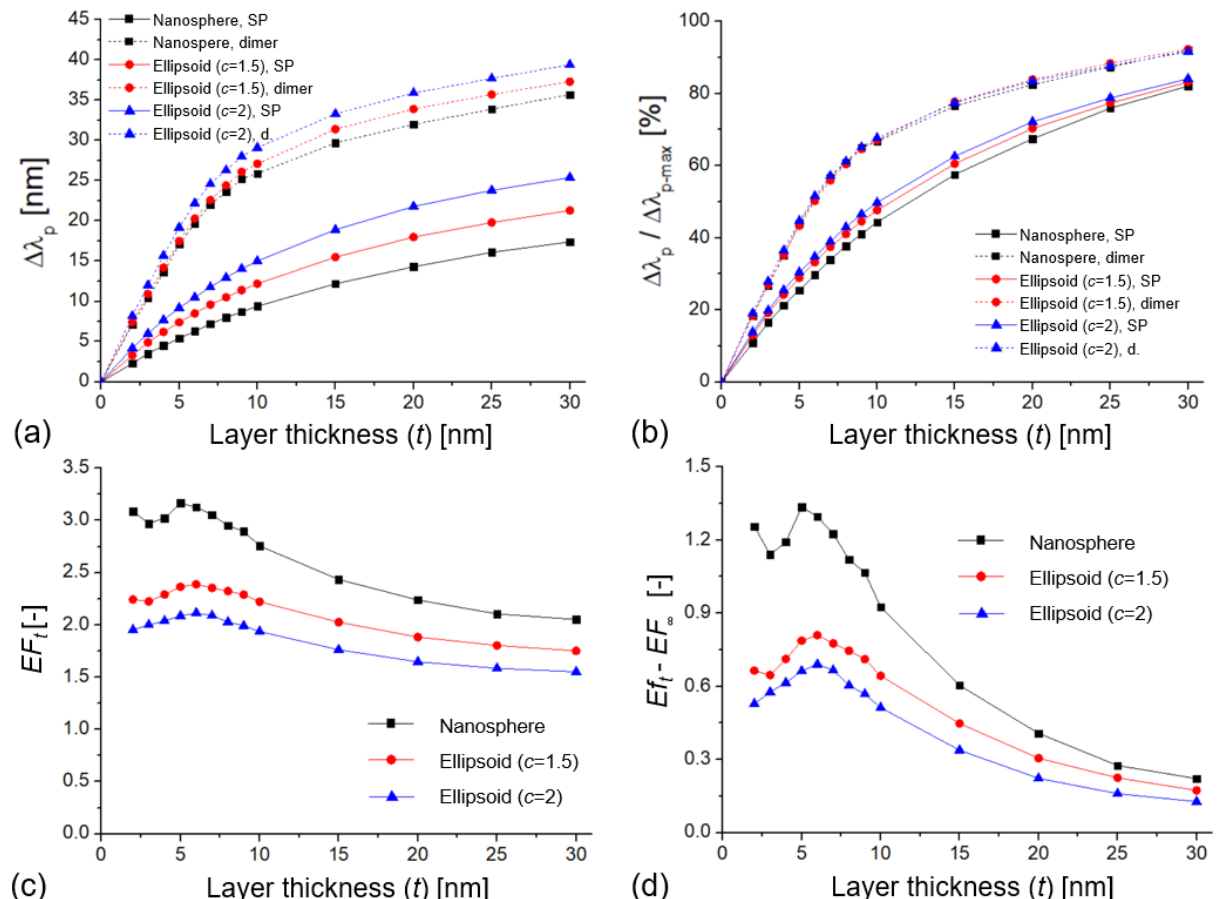
Figure 4. ( a ) Extinction peak shift ( ∆ λ p ) of different single-particle and dimer arrangements as a function of the deposited dielectric layer thickness ( n l = 1.5 in water, medium with n = 1.33). The diameter of the particles was 70 nm, with a 10 nm interparticle gap ( D / D 0 = 0.14). ( b ) The relative extinction peak shift as a function of the layer thickness where ∆ λ p − max was calculated as the peak shift upon changing the RI of the medium from 1.33 to 1.5. ( c ) Enhancement factor ( EF t ) as a function of the layer thickness. ( d ) Difference between surface and bulk enhancement factors ( EF t − EF ∞ ) as a function of the layer thickness.